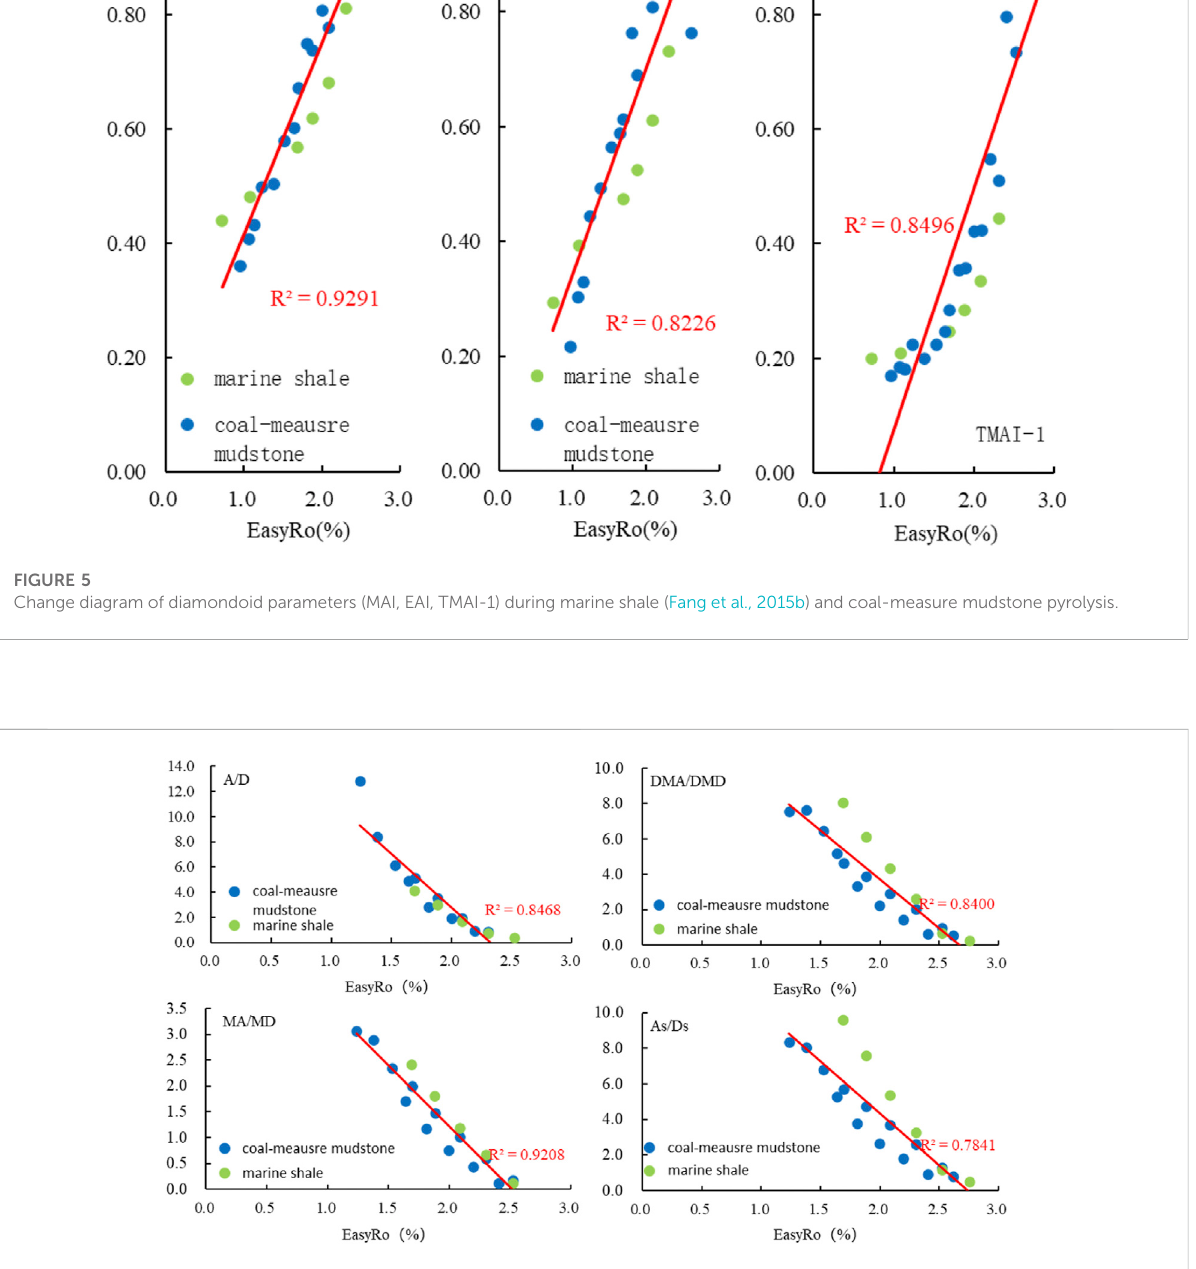
Change diagram of diamondoid yield ratios (A/D, MA/MD, DMA/DMD, As/Ds) during marine shale (Fang et al., 2015b) and coal-measure mudstone